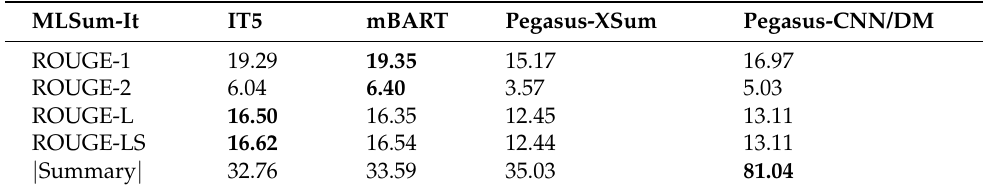
Table 3. Comparison between IT5, mBART, Pegasus-XSum and Pegasus-CNN/DM using the same MLSum-It test set. IT5 and mBART are trained on MLSum-It, while the two Pegasus models are pre-trained. | Summary | is the length of the summary in terms of the number of words. The best results reported in the table are highlighted in bold.